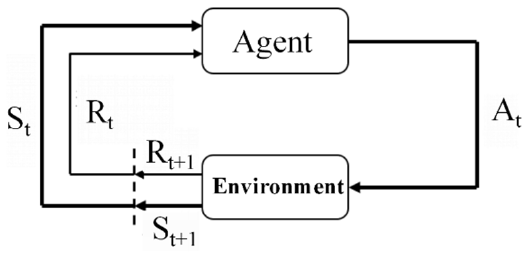
Figure 6. MDP model.